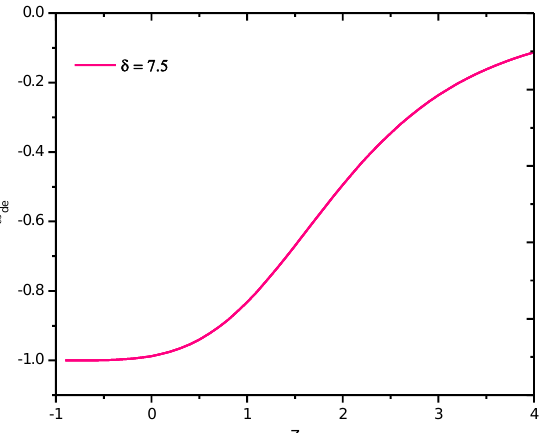
Figure 6. Behavior of EoS parameter of Sharma–Mittal holographic dark energy f ( T , B ) gravity model in Hubble’s horizon cutoff versus redshift for the appropriate choice of constants d = 1.82, C 2 = 0.1, β = 6, m = 14, m 1 = 0.001, n = 10 and n 1 =